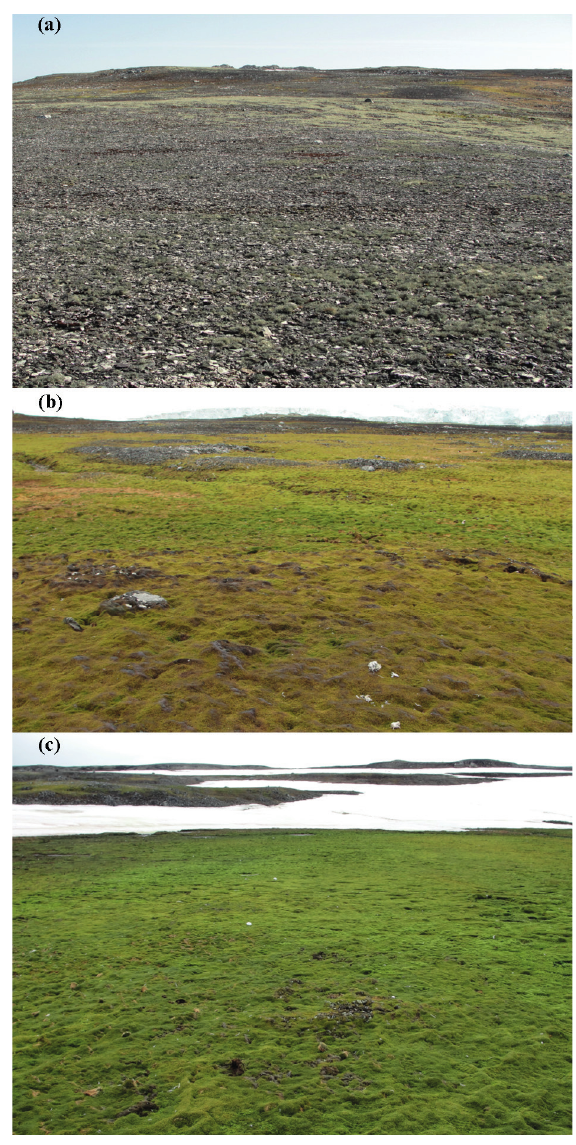
Figure 2. Harmony Point, Nelson Island, photographs showing different biological soil crusts: lichens (a), mosses (b) and algaes